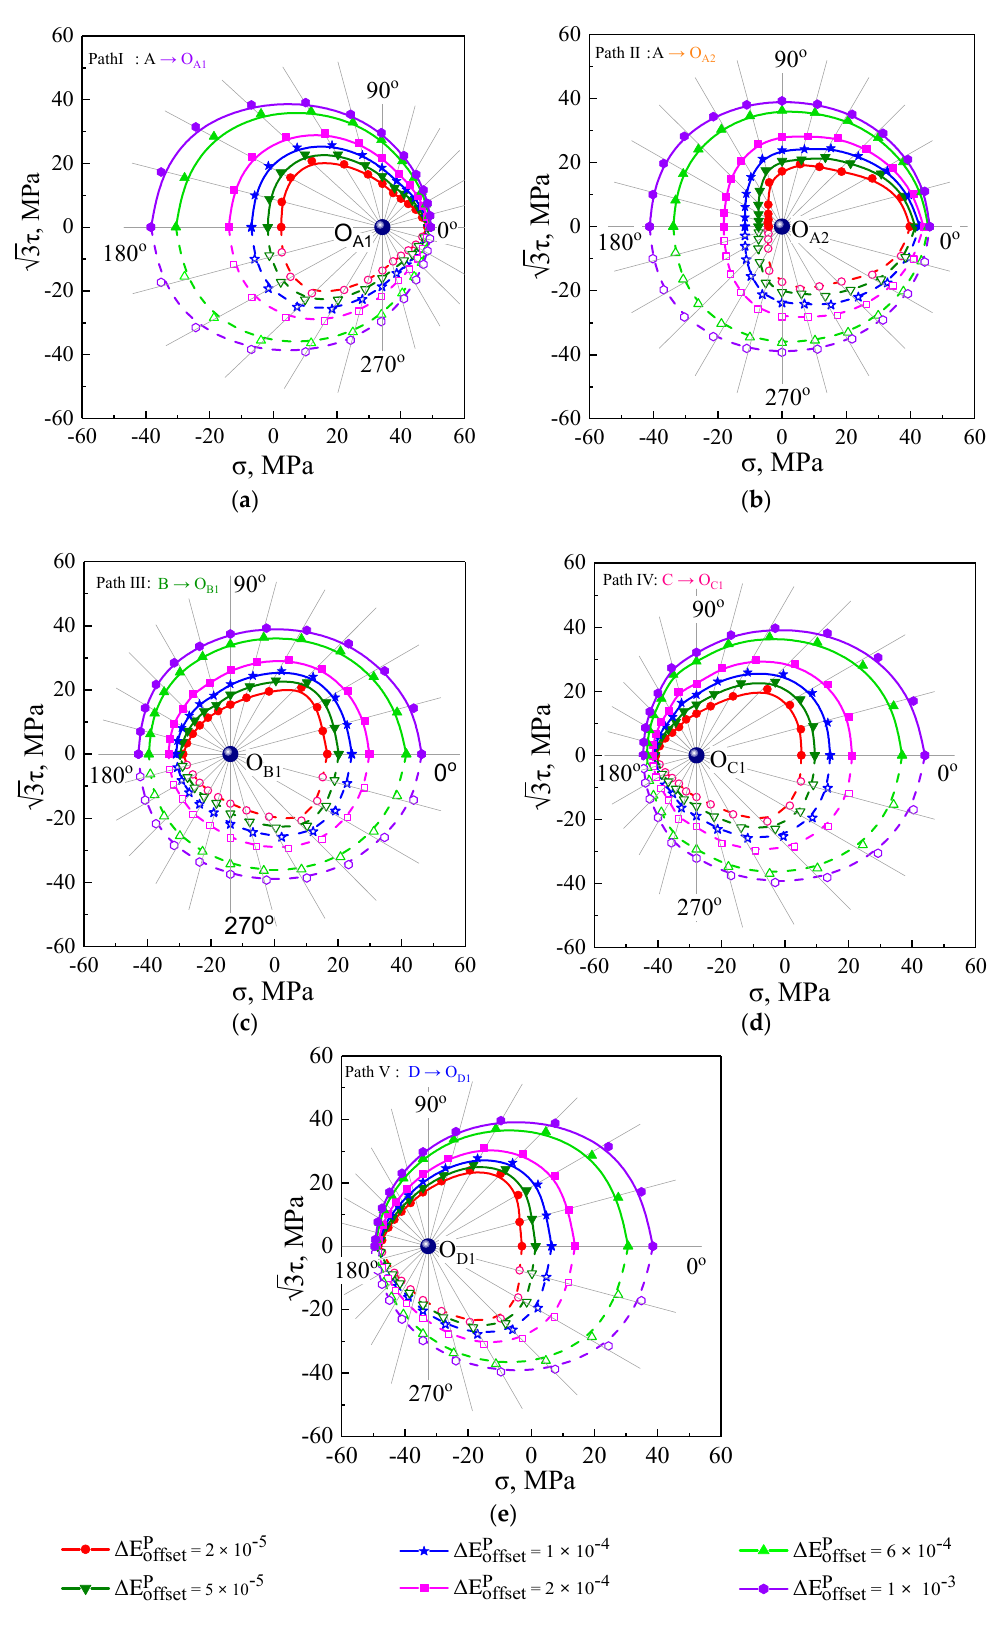
Figure 10. Subsequent yield surface at five different unloading paths by crystal plasticity simulation: ( a ) from A to O A1 ; ( b ) from A to O A2 ; ( c ) from B to O B ; ( d ) from C to O C ; ( e ) from D to O D .